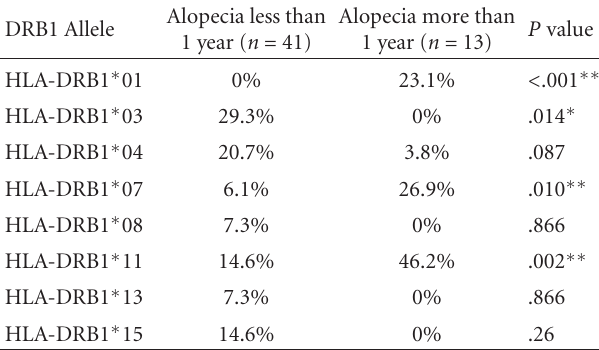
Table 5: Frequencies of selected HLA-DRB1 alleles in Alopecia of less than 1 year duration compared to alopecia with a duration of more than 1 year using Chi square